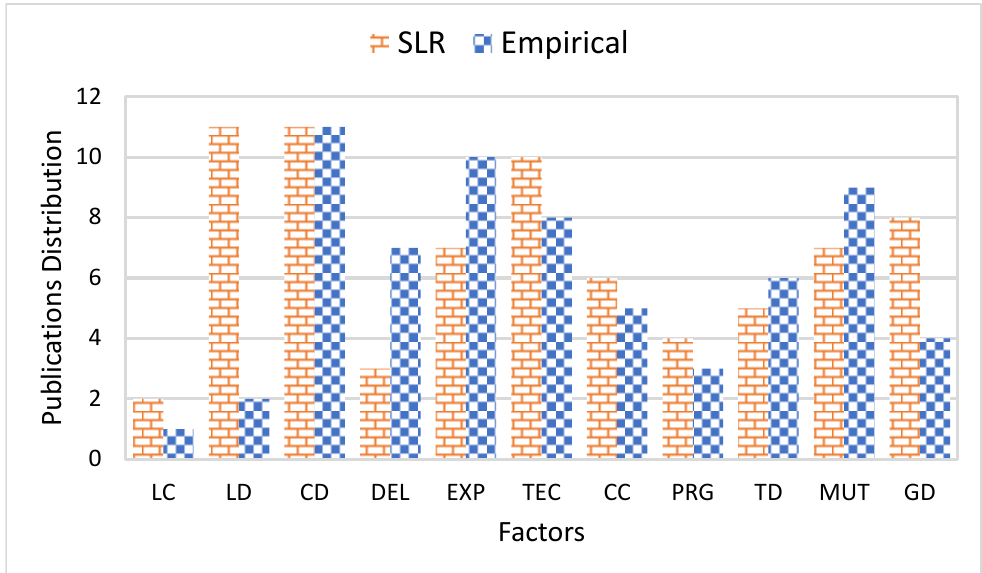
Figure 6. Comparison of SLR and empirical